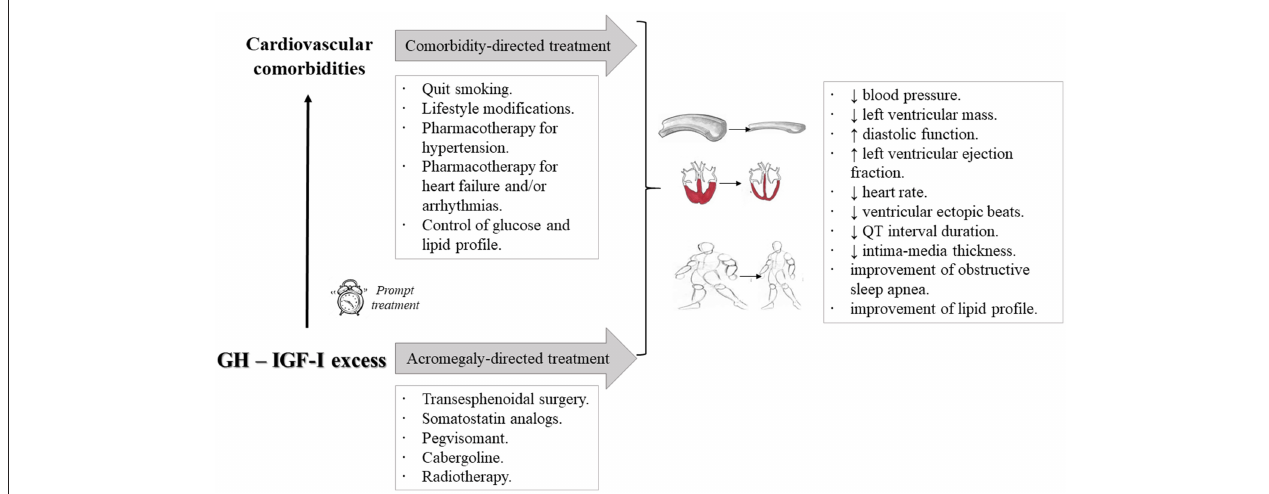
FIGURE 2 | Schematic representation of the therapeutic approach to acromegalic patients with cardiovascular comorbidities and its reported effects. It is worth emphasizing that a prompt initiation of treatment allows a higher probabilitiy of cardiovascular control. In fact, regression of established alterations may be even feasible. A general management should be warranted, including smoking cessation, lifestyle modifications, and optimal pharmacotherapy for each of the potential problems encountered, including adequate control of glucose and lipid profiles. Besides, control of GH/IGF-I excess with the available acromegaly-directed treatment modalities further ameliorates cardiovascular comorbidities. ↓ : decrease; ↑ :